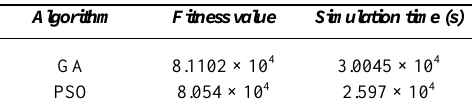
Table 3. Final results of GA and PSO. Algorithm